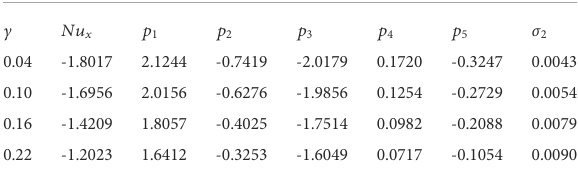
TABLE 6 Nusselt quantity ( Nu x ) and ideal relative error bound ( σ 2 ) for various values of time-dependent variant ( ξ ) and radiative variable ( N r